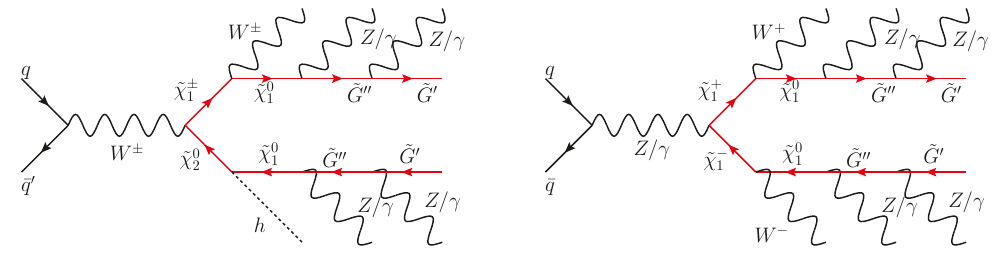
Figure 1 . Typical signal Feynman diagrams with four Z/γ